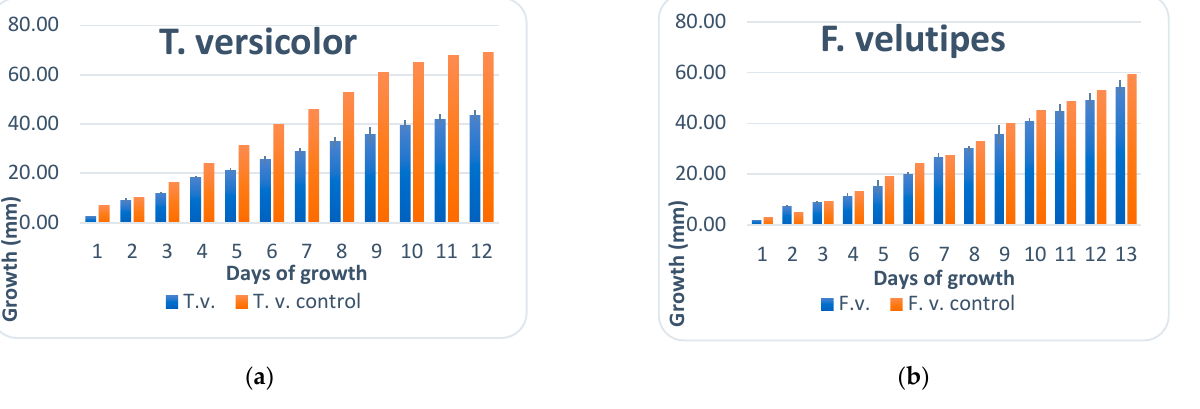
Figure 1. ( a ) T. versicolor: blue histograms represent growth of the UV exposed samples and the orange histograms control; ( b ) F. velutipes: blue histograms represent growth of the UV exposed samples and the orange histograms are the